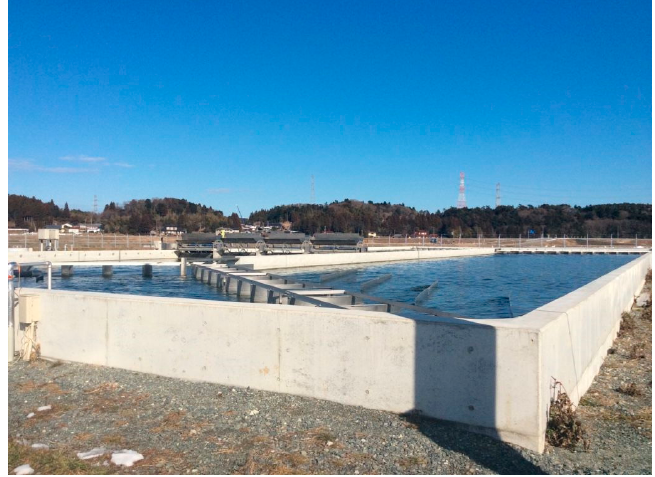
Figure 2. Raceway pond (1000 m 2 scale).